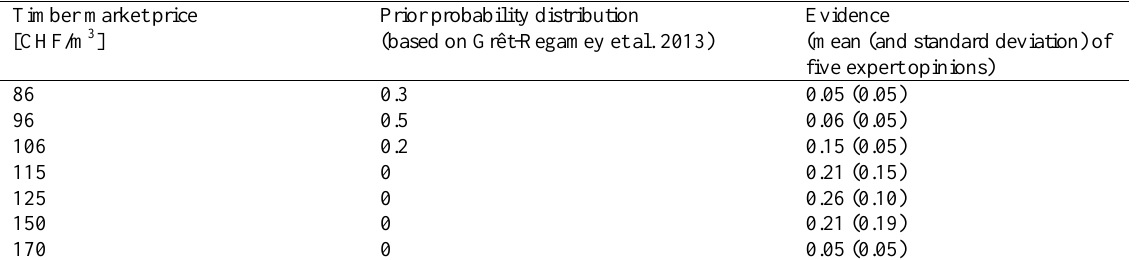
Table A3.1. Prior probability distribution of timber price and evidence provided by experts. The evidence that was fed into the Bayesian Network was calculated as the mean value of the probability estimates for each state of the node provided by the single experts.